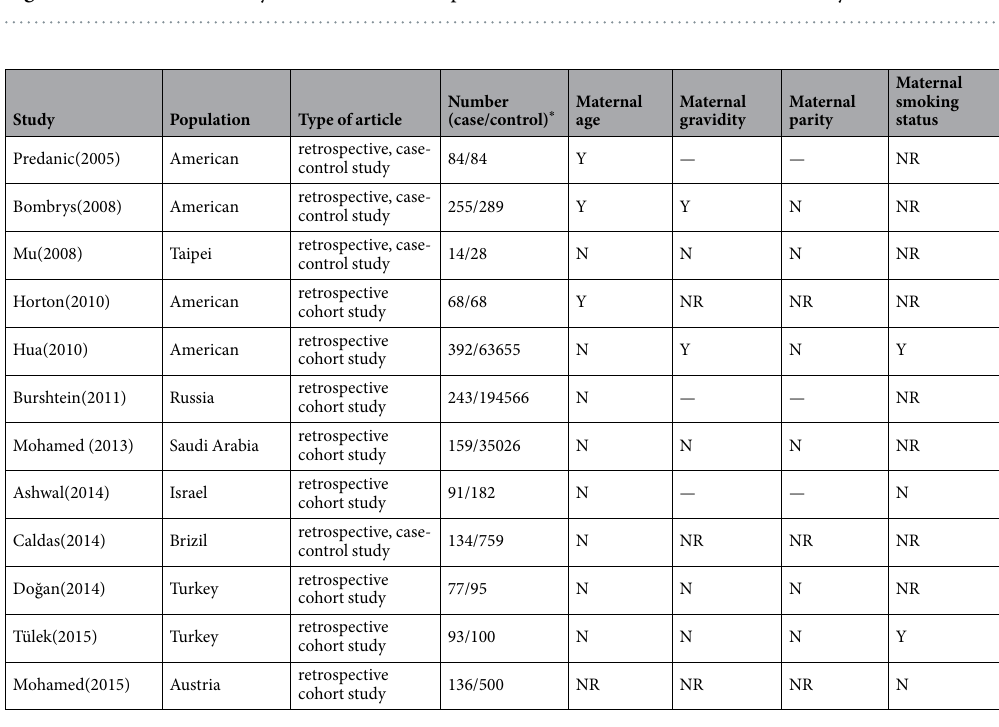
Figure 1. Flow chart of study selection and description of exclusion criteria for the mete-analysis.